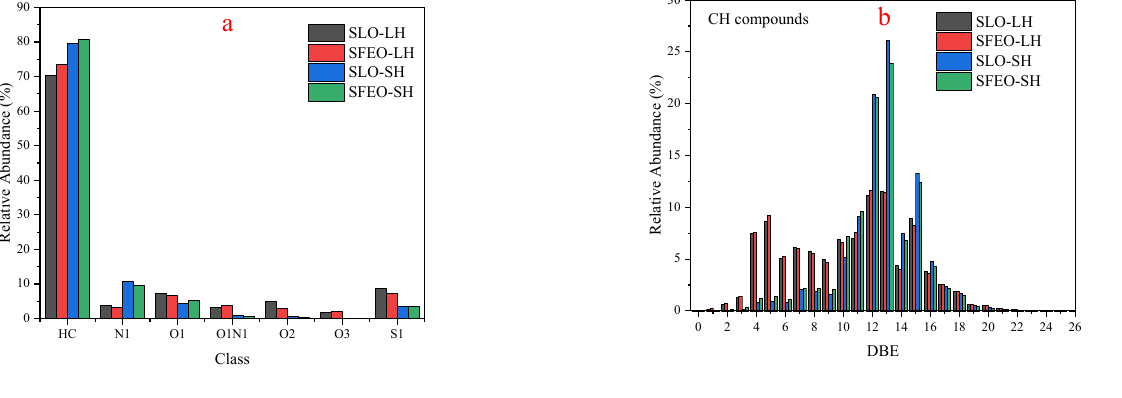
Figure 6. Relative abundance of various class compounds, ( a , b ) relative distribution of CH com- pounds with different condensation degrees in SLO–LH and SFEO (APPI).